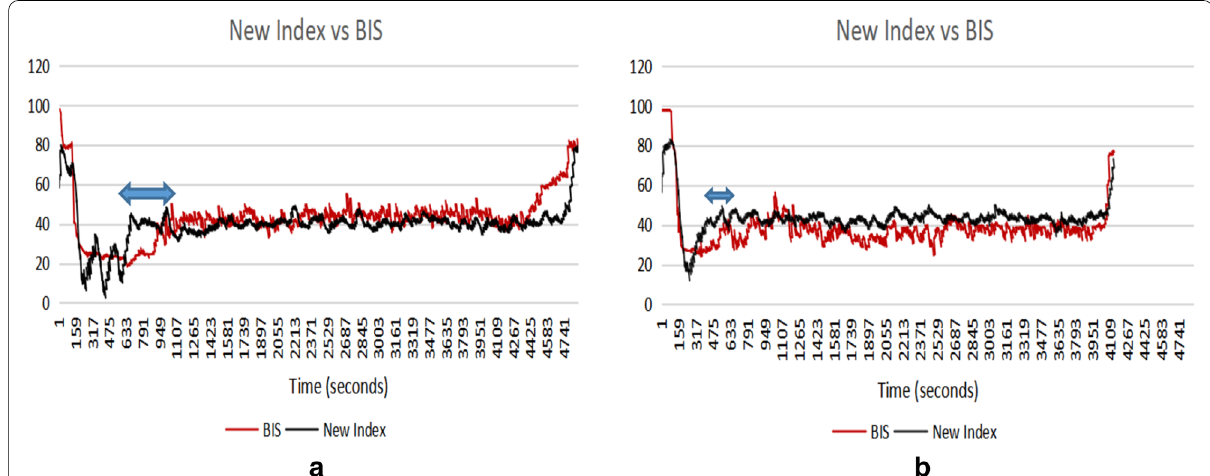
Fig. 11 The comparison of the new index and the BIS index. a Patient ID 9; b Patient ID 12. The blue markers show the earlier reaction by the new index